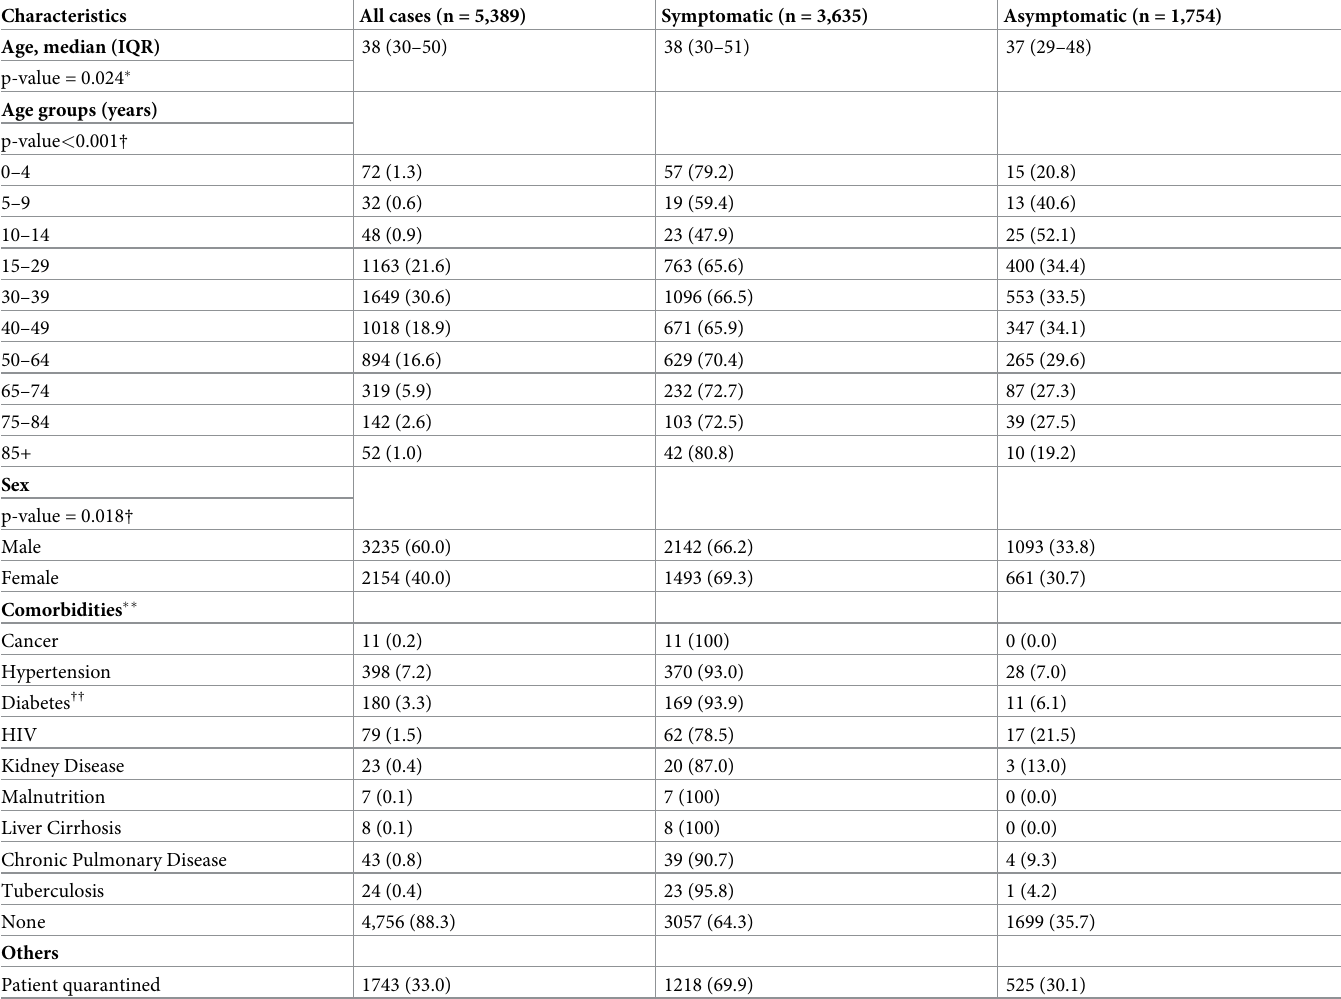
Table 1. Characteristics of all COVID-19 cases, by symptom status, Haiti, March to August 2020.